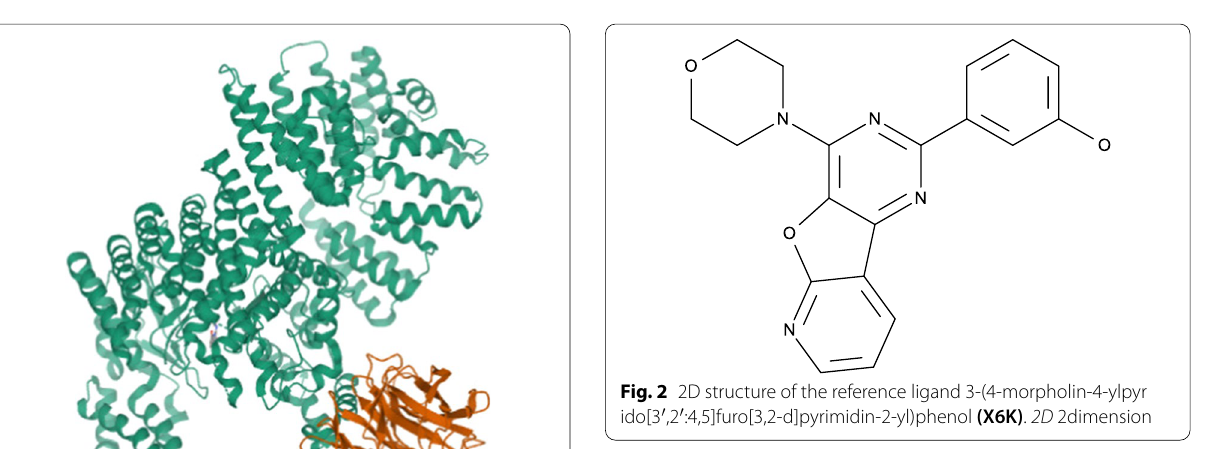
the receptor and maps have been correctly set up, then the docking procedure could begin. The SD files of the optimised ligands are imported into the ICM programme as chemical spreadsheet. To dock directly from a chemi- cal table, the chemicals in the table to be docked were selected. On the docking menu, dock chemical table was selected and after the docking process is finished, the hit- list were displayed. The docking results are then exported as a spreadsheet file saved in csv format. After docking the binding modes and interaction of the best ligand-receptor complexes are displayed by right clicking the ligand docked in the ICM window and saving the file output as a pdb file. The saved file was then imported into the discovery studio visualiser, where the 2D and 3D interactions could be prop- erly seen. The receptors, after treatment, were docked with their respective ligands. Five types of interaction potentials that represent the receptor pocket includes van der Waals